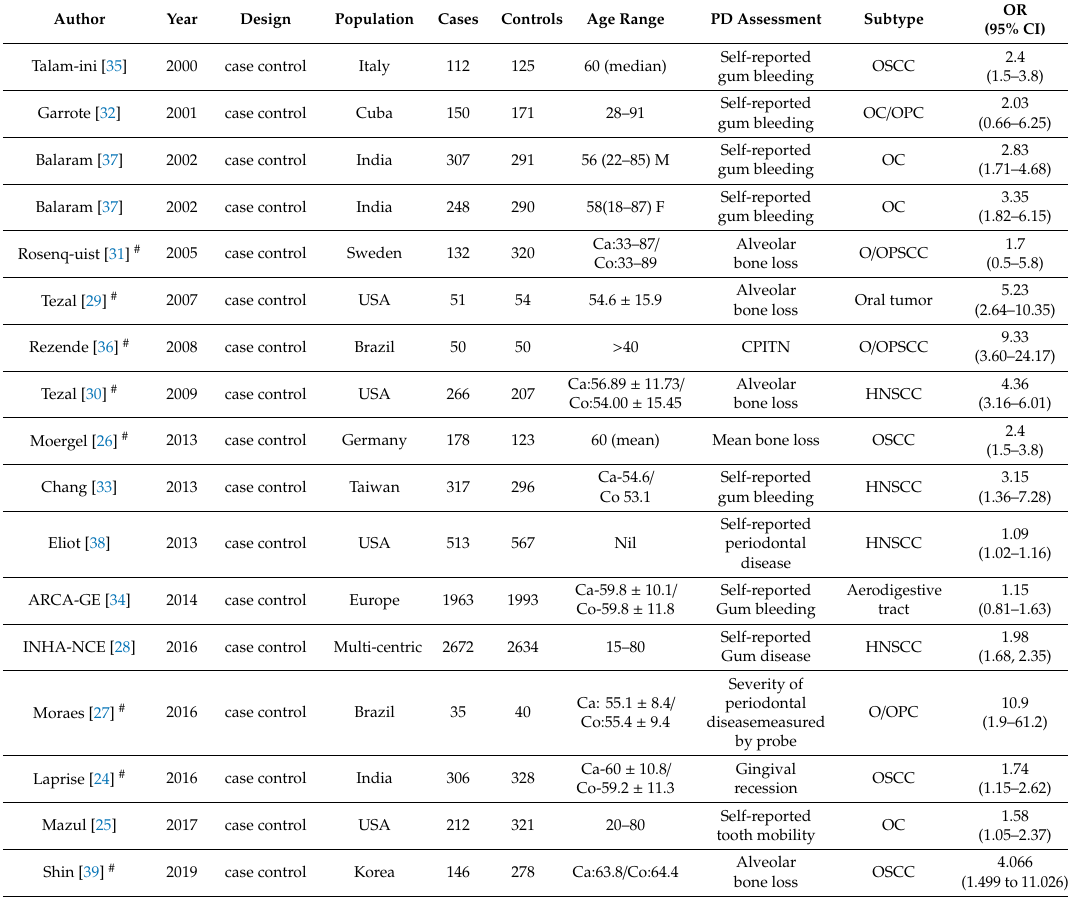
Table 1. Characteristics of selected case control studies in